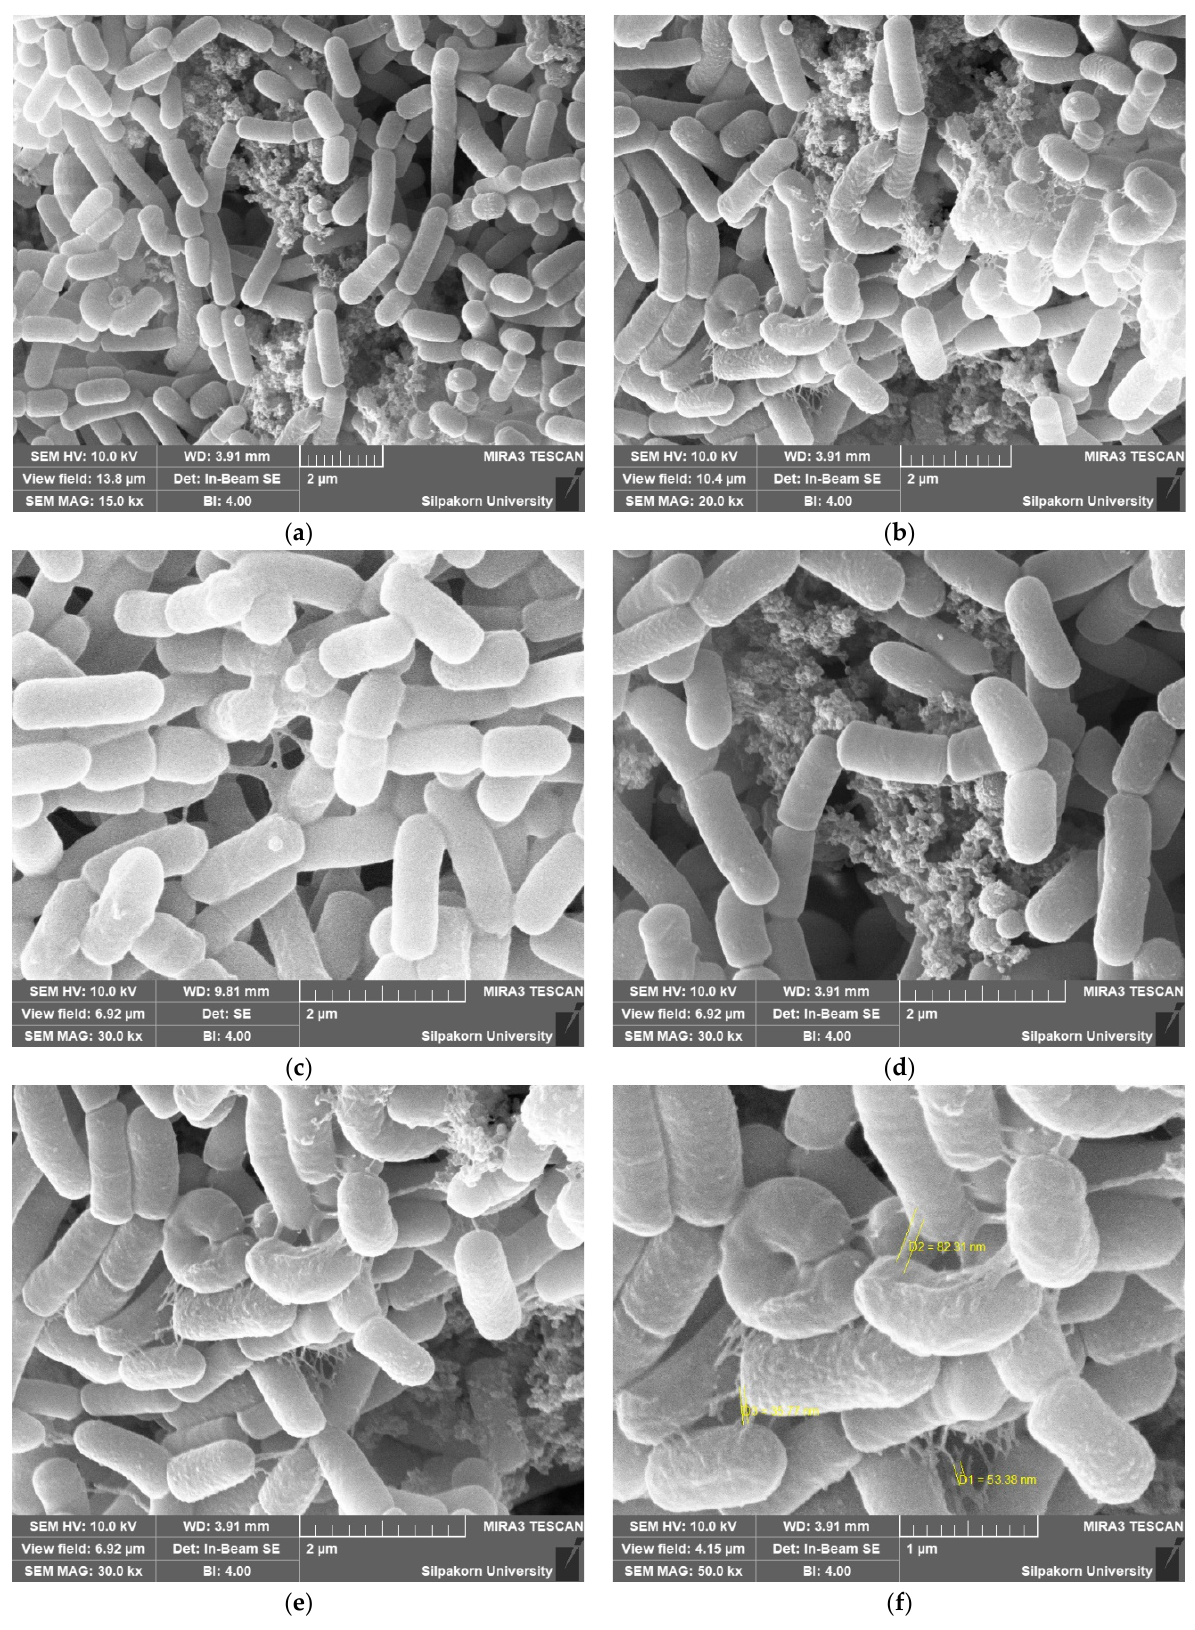
Figure 3. SEM of multi-strain probiotic product after freeze-drying in the presence of complex medium as protectant wall materials. (Magnification: ( a ) 15,000×, ( b ) 20,000×, ( c – e ) 30,000×, ( f ) 50,000×).